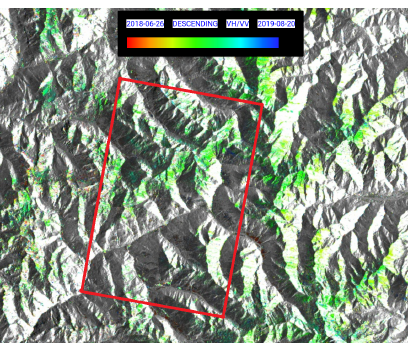
Figure 7. Sentinel-2 Image on the area footprint selected over the Guil Basin